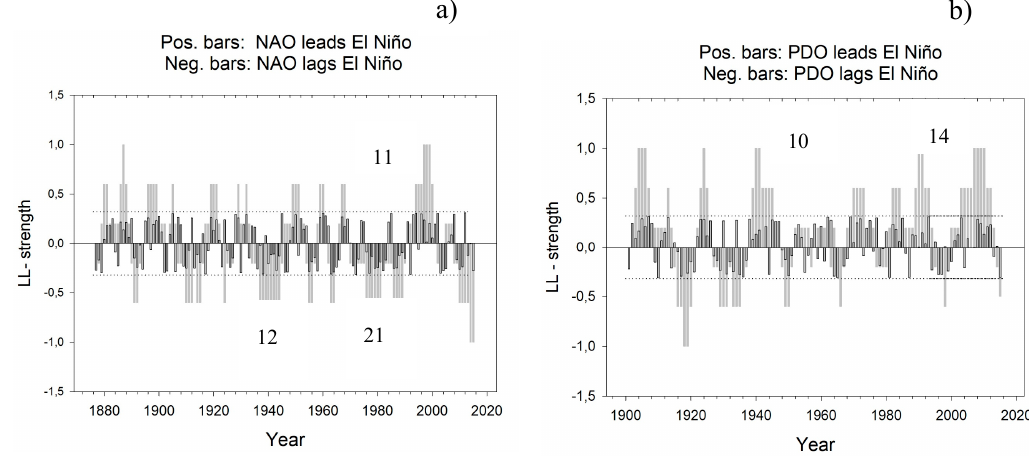
Figure 6. Persistent leading–lagging relations. ( a ) LL relations for the North Atlantic Oscillation (NAO) and El Niño. Black bars show rotational angles and gray bars show the average LL relations with window length 5. NAO leads El Niño significantly in 29 years and lags El Niño significantly in 36 years; in sum, there is a significant LL relation 43% of the time. ( b ) LL relations for the Pacific Decadal Oscillation (PDO) and El Niño. Black bars show rotational angles and gray bars show the average LL relations with window length 5. PDO leads El Niño significantly in 38 years and lags El Niño significantly in 16 years; in sum, there is a significant LL relation 47% of the time.